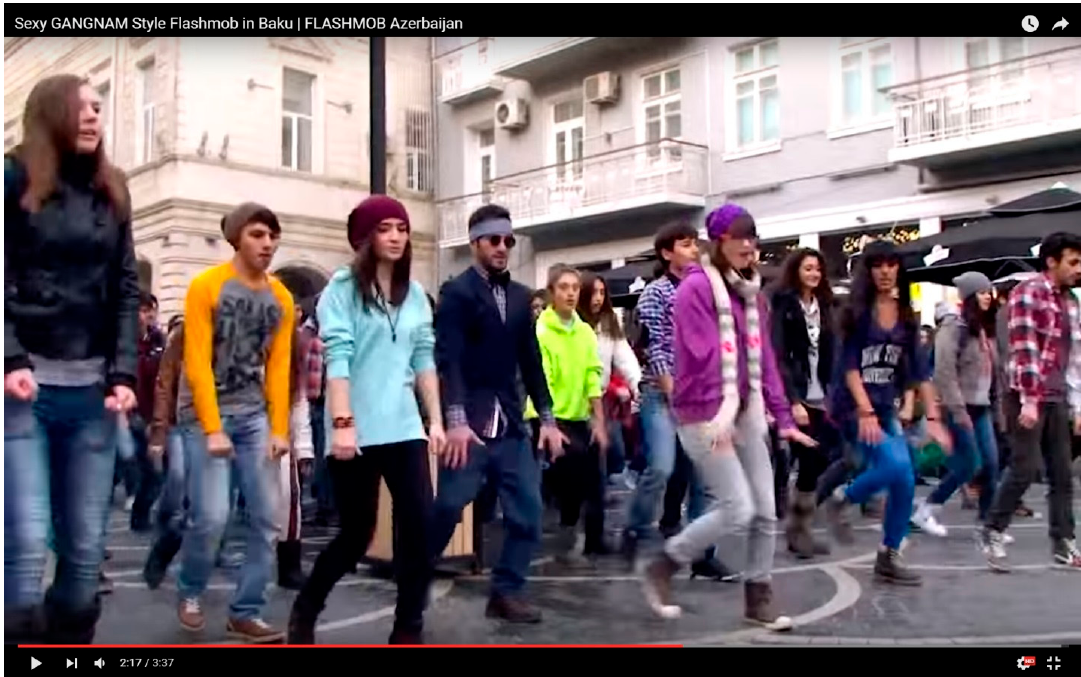
Figure 1. A scene from Sexy Gangnam Style flash mob [40].